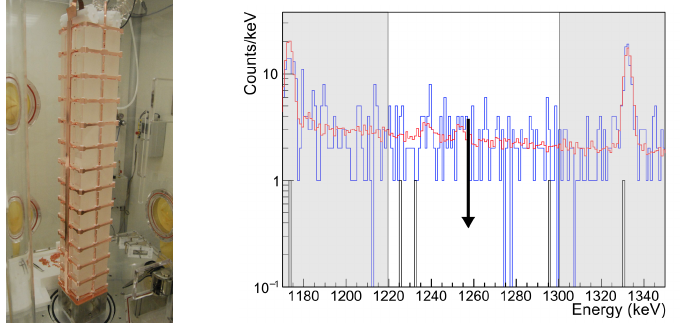
Figure 15. ( left ) The CUORE-0 tower (reprinted from Reference [107] with permission from IOP Publishing). ( right ) CUORE-0 spectra for the one of five signatures selected for the 2 ν 2 β − decay of 130 Te to the 0 + level of 130 Xe. The blue histogram shows the data without any energy related cut; 1 the reconstruction of the background model is shown in red; in black are data with energy cuts [72]. The black arrow points to the location of the expected peak. In particular this scenario considers three hits from 3 different detectors, in the same coincidence time window. One crystal must contain a signal with energy in the range ( 734 ± 5 σ ) keV; another one must have energy in the ( 536 ± 5 σ ) keV range. No requirement is imposed on the energy deposited in the third crystal. Reprinted from Reference [72] under the terms of the Creative Commons Attribution 4.0